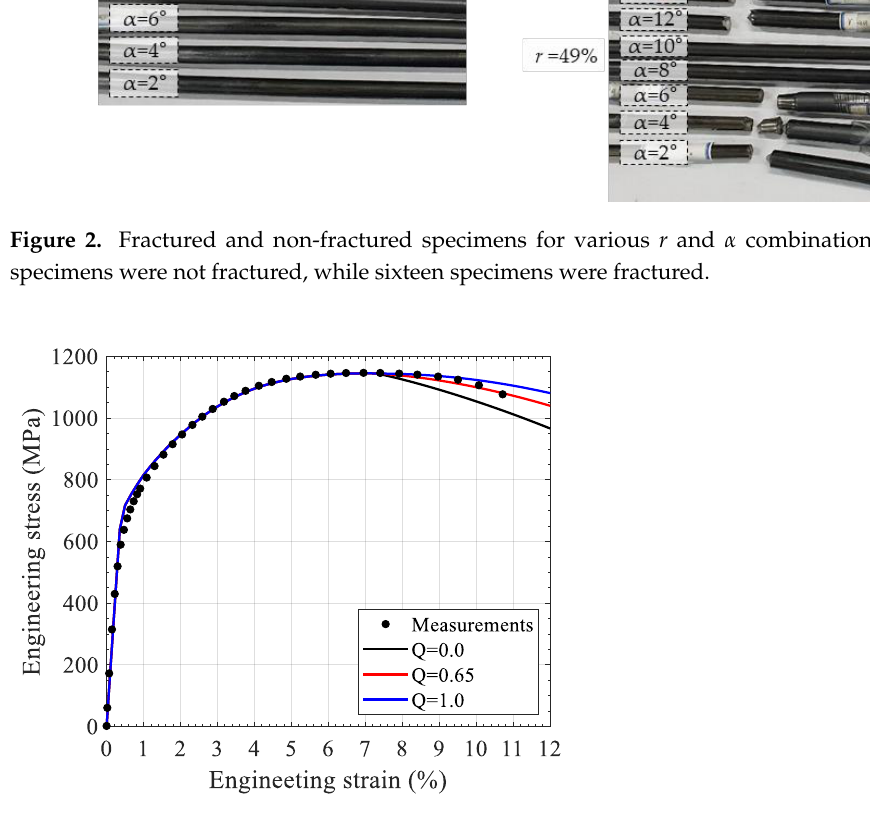
Figure 2. Fractured and non-fractured specimens for various r and α combinations . Thirteen speci- mens were not fractured, while sixteen specimens were fractured.